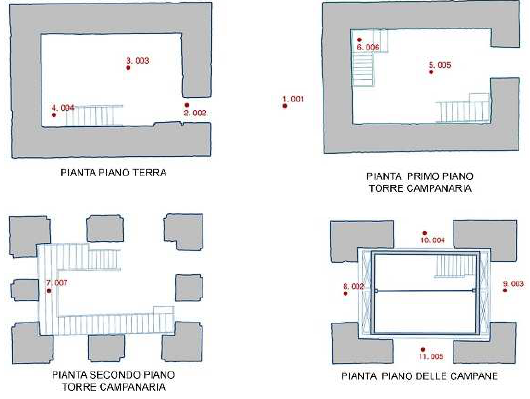
Figure 3 - Internal stations in San Ciriaco’s belfry The whole cloud, including the external square, resulting from the alignment of the 29 stations, has a maximum error of 4 mm (3 mm due to the instrument and 1 mm due to the alignment).